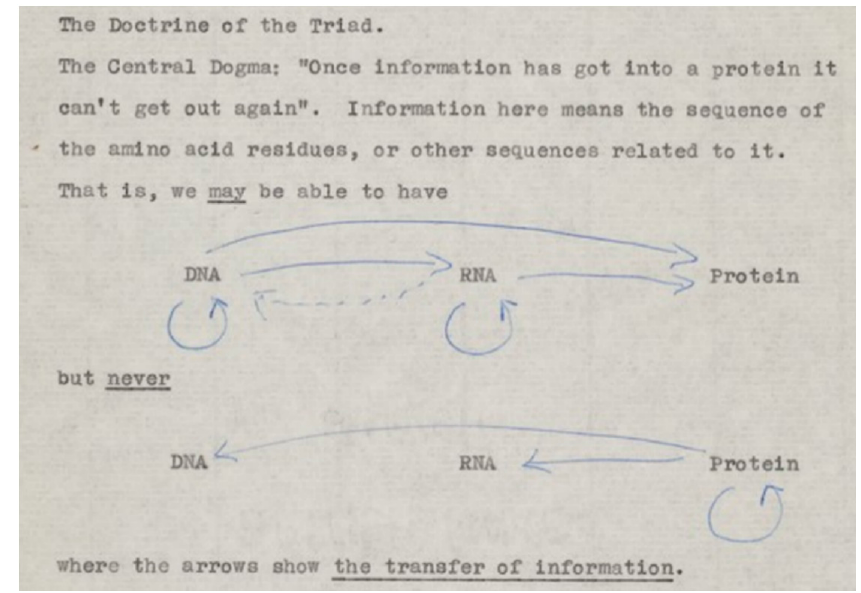
Figure 5. The central dogma of molecular biology [47].